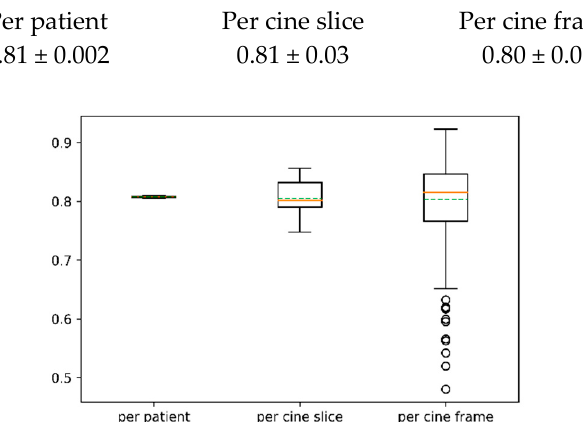
Figure 6. Dice Score boxplots for the independent testing datasets. In the boxplot, the orange line indicates the median value, the green line indicates the mean value and the dots around indicate the outliers. Outliers here are defined as data points above Q3 + 1.5 × IQR or below Q1 − 1.5 × IQR of the distribution. (Q1: first quartile, Q3: third quartile, IQR: interquartile range (Q3–Q1).)